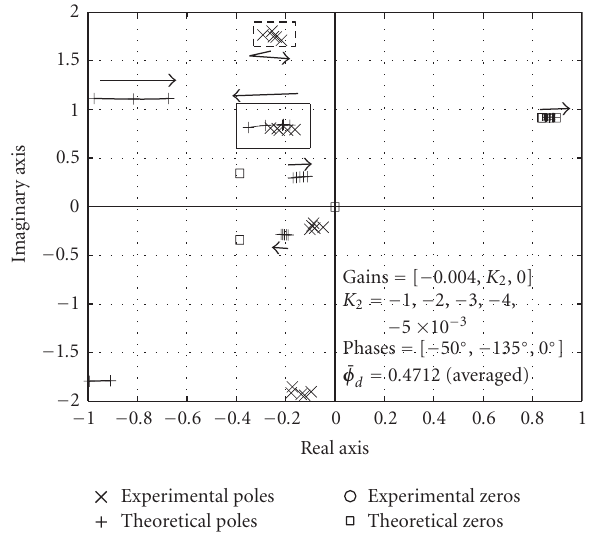
Figure 12: Closed-loop root locus for harmonic 2 with varying gain.